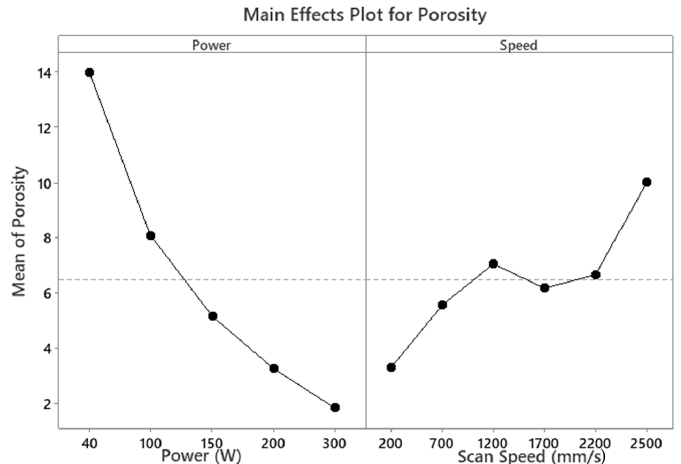
Figure 6. Individual impact of laser power and scan speed on the mean of porosity.